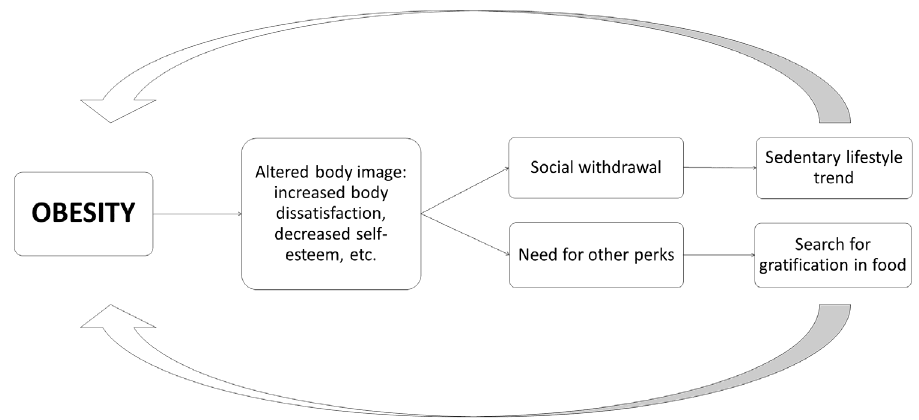
Figure 2. Example of how a consequence of obesity in the psychological field can enhance it [58].